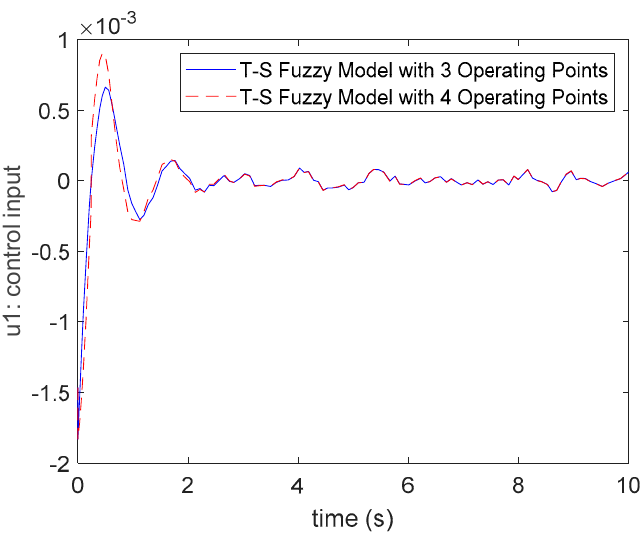
Figure 7. The comparisons of control input ( )